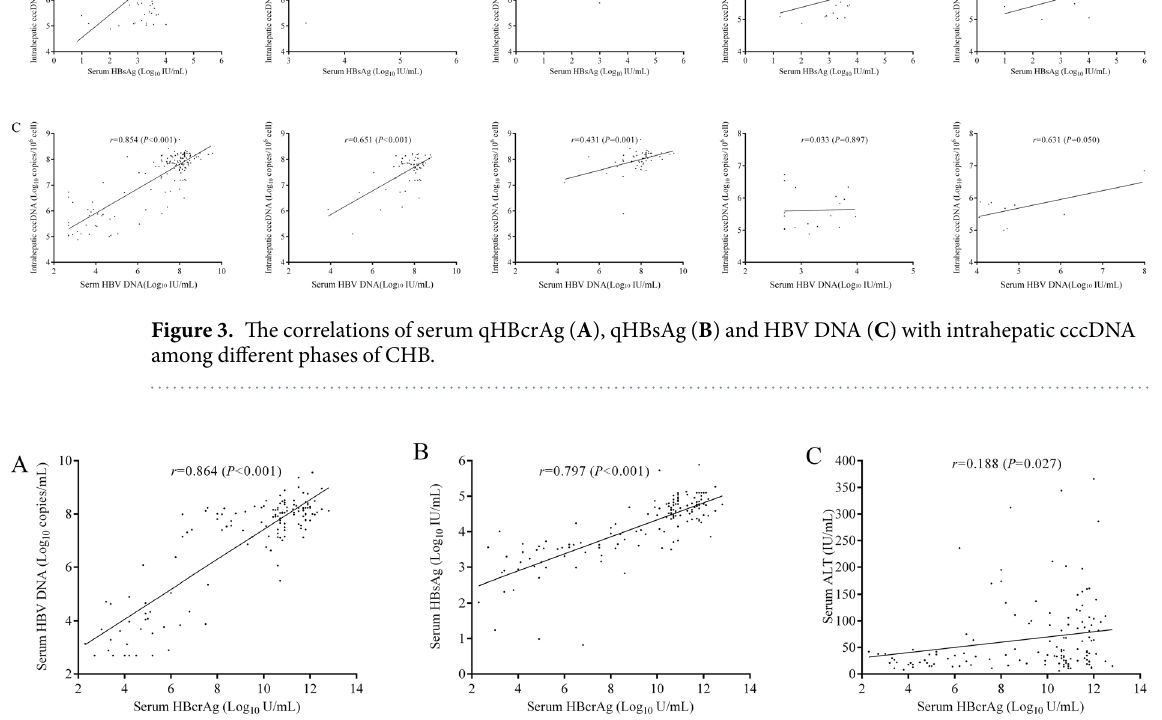
Figure 4. The correlations of serum qHBcrAg with serum HBV DNA ( A ), qHBsAg ( B ) and ALT ( C )